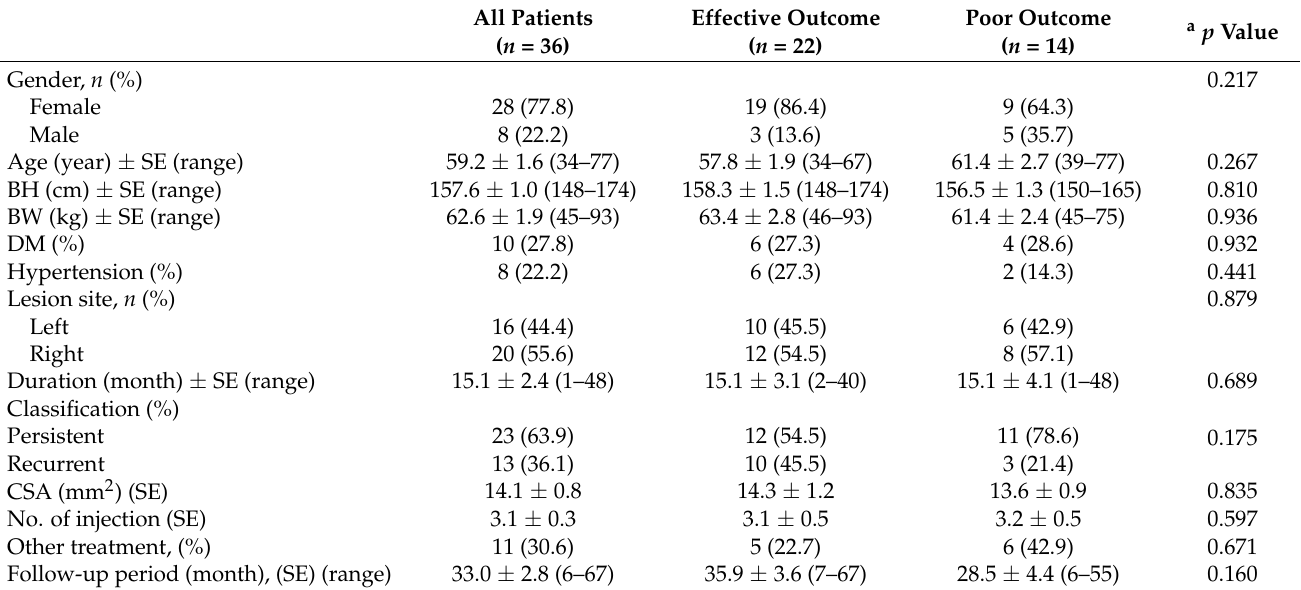
Table 1. Demographic information of all patients and different outcomes.